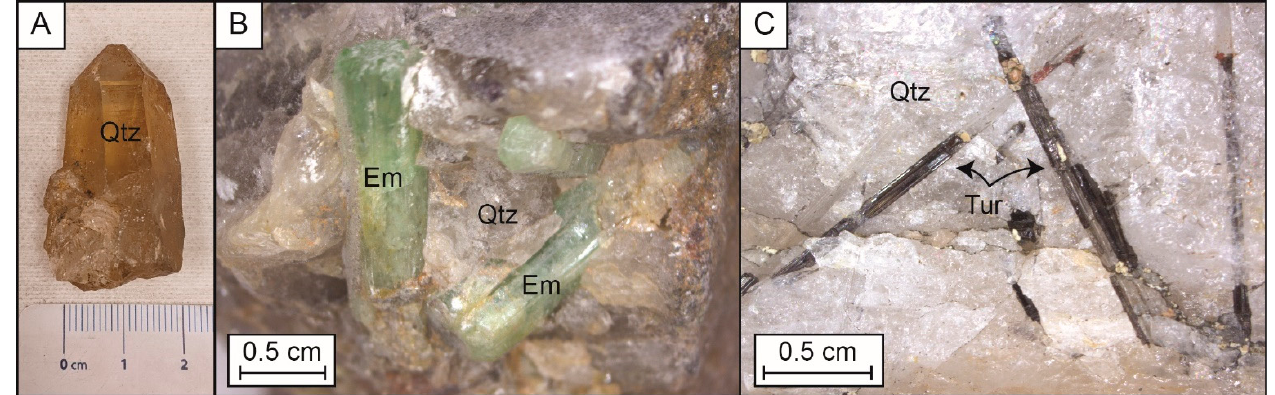
Figure 2. Photographs of the main minerals of interest of the Lened deposit. ( A ) Cm-sized euhedral quartz, ( B ) Intergrown euhedral quartz and emeralds, and ( C ) Intergrown anhedral quartz and euhedral tourmaline. Em: emerald (beryl), Qtz: quartz, Tur: tourmaline.